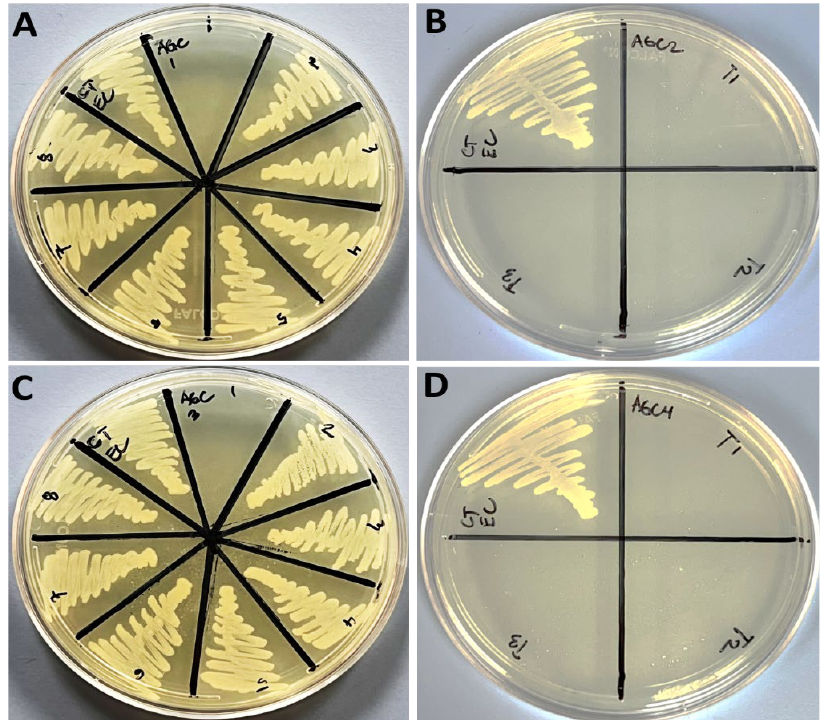
Figure 5. MBC (mg/mL) results of the NPs ( A ) Ag-C-1, ( B ) Ag-C-2, ( C ) Ag-C-3 and ( D ) Ag-C-4 against E. coli .